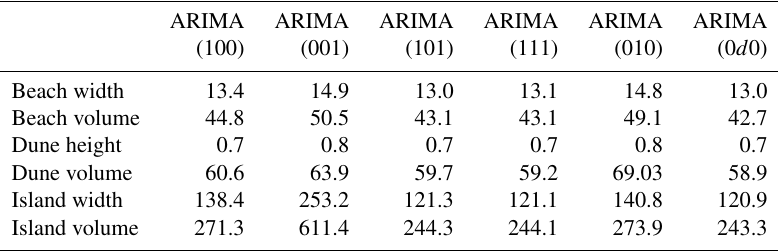
Table 2. Comparison of residuals (RMSE) of each ARIMA model for all spatial data series. Note that the residuals for each DEM metric correspond to the analysis performed at the regional scale (i.e.,